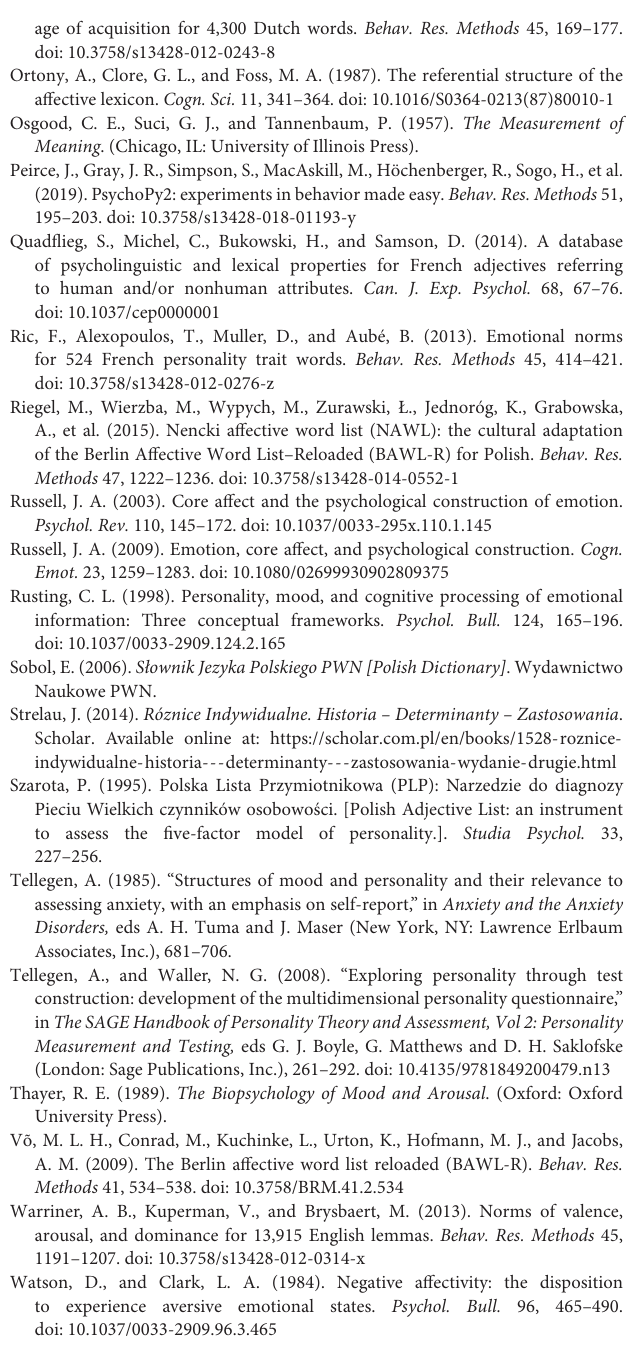
Supplementary Table 1 | List of 400 adjectives and their ratings on valence, arousal, category, and social judgments dimensions alongside linguistic (frequency and word length)